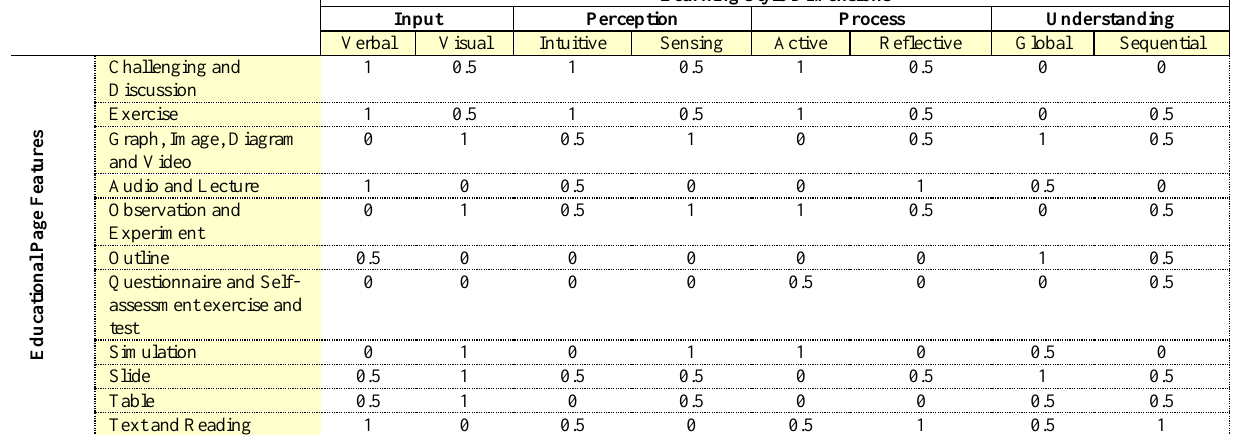
Table 2. Relation between Learning Styles Dimensions and Resource Learning Pages. Learning Style Dimensions Input Perception Process Understanding Verbal Visual Intuitive Sensing Active Reflective Global